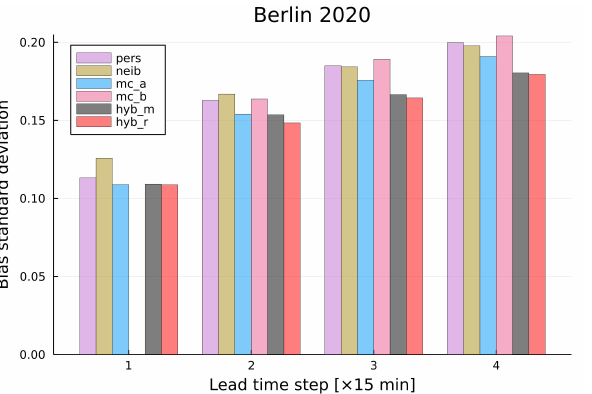
Figure 9. Standard deviation of CMF prediction bias for Berlin. The results for the other three cities can be found in Figure A2 in Appendix